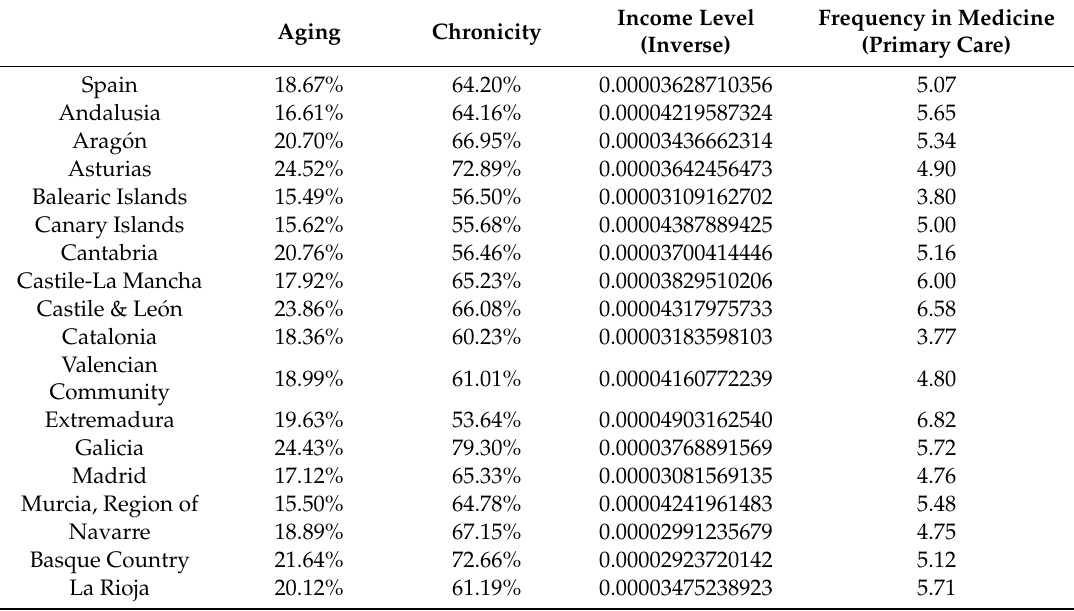
Table 4. Analysis of Aging, Chronicity, Income Level (Inverse), Frequency in Medicine (Primary Care). Aging